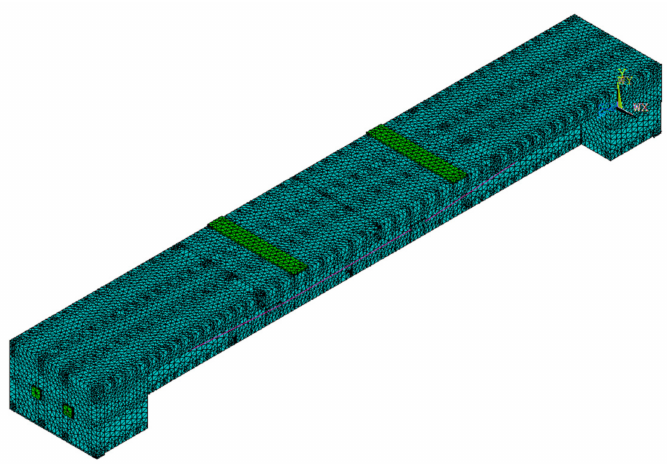
Figure 9. Developed finite element model in